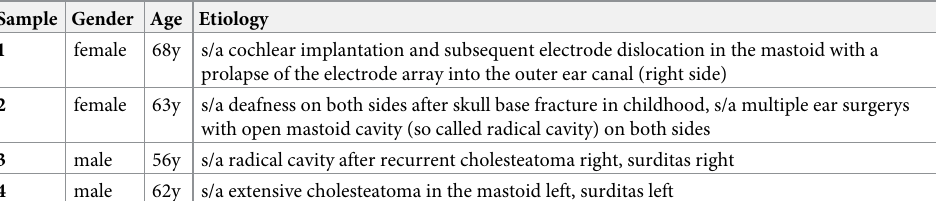
Table 1. Patient information for human